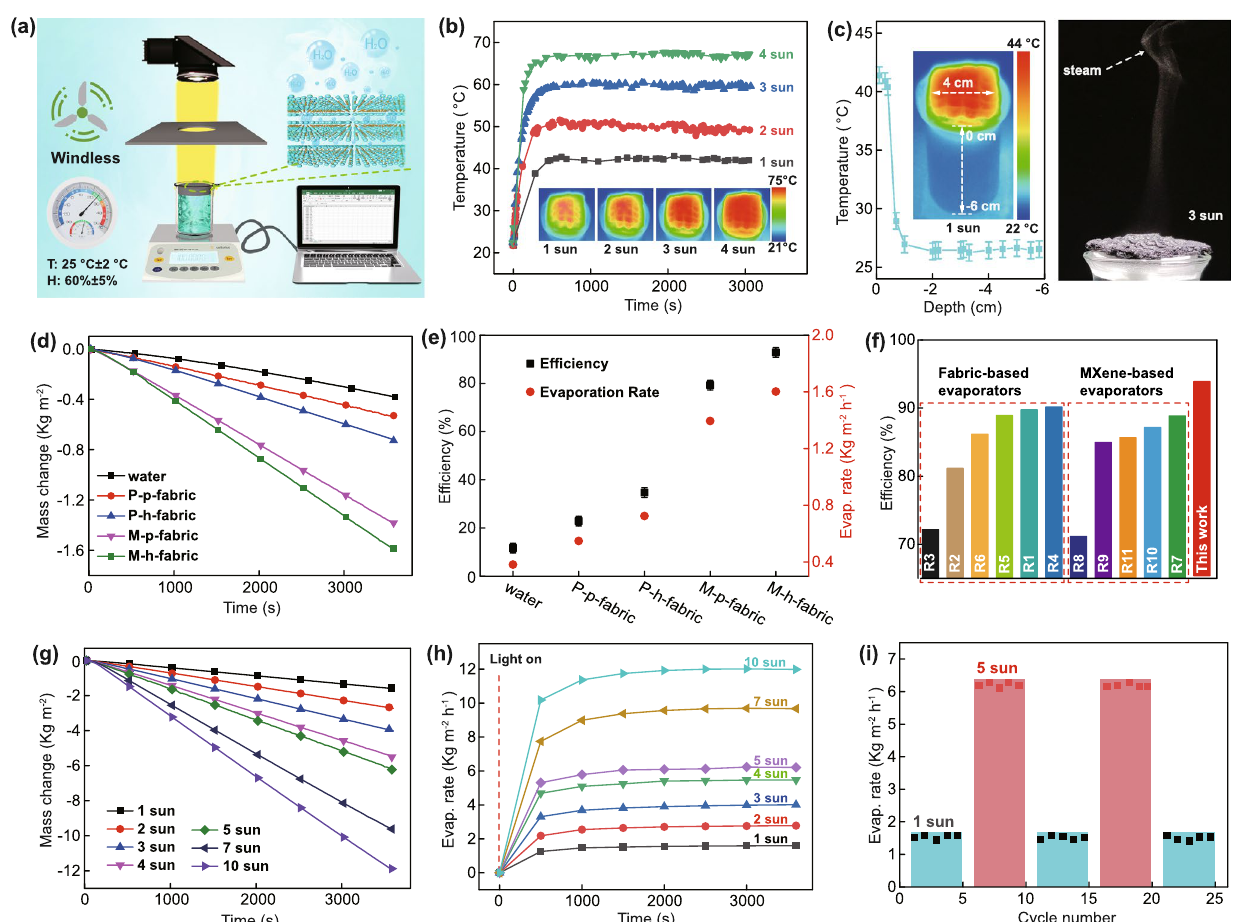
Fig. 4 a Schematic diagram of the system used to test the solar vapor generation performance of the evaporator. b Variations in the surface tem- perature of the honeycomb fabric with irradiation time under different light intensities. Inset: IR image of the honeycomb fabric surface. c Lon- gitudinal temperature distribution of the evaporator under 1 solar intensity (left panel) and water vapor generated under 3 solar intensities (right panel). d Changes in the evaporation mass of water, P-p-fabric, P-h-fabric, M-p-fabric, and M-h-fabric under the illumination of 1 solar intensity (sample names: P = pristine, M = MXene, h = honeycomb, p = plain). e Evaporation rate and efficiency of water, P-p-fabric, P-h-fabric, M-p-fab- ric, and M-h-fabric under the illumination of 1 solar intensity. f Comparison of the evaporation efficiency of the M-h-fabric prepared in this work with those of previously reported evaporators. g Variations in the evaporation mass of the M-h-fabric over time under different solar intensities. h Evaporation rate of the M-h-fabric under different solar intensities. i The cycle stability of evaporation performance for the M-h-fabric under different solar intensities. Each cycle was sustained for 1